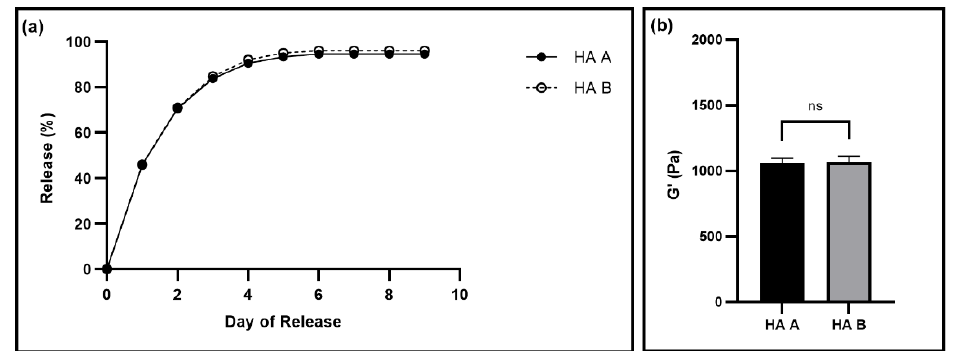
Figure 1. Evaluation of gels made with TEOS from two different manufactures, denoted TEOS A and TEOS B. PBS gels were used for all tests as to focus entirely on the effect of the TEOS. ( a ) The release profiles of fluorescein with N = 3. Error bars hidden by plot symbols when not visible. A t - test was used to compare release from the gels each day, indicating no statistically significant dif- ference between the release profiles (Table S1). ( b ) Storage moduli for gels made using TEOS from two different manufacturers. Mean and standard deviation are displayed from data collected with N = 3. An unpaired t -test was used to compare the means, resulting in a p -value of 0.5430, with ns indicating no significant difference between the means. ( c ) Dry substance percentage for gels made using the two different manufacturers. Mean and standard deviation are displayed from data col- lected with N = 3. An unpaired t -test was used to compare the means, resulting in a p -value of 0.5069, with ns indicating no significant difference between the means.